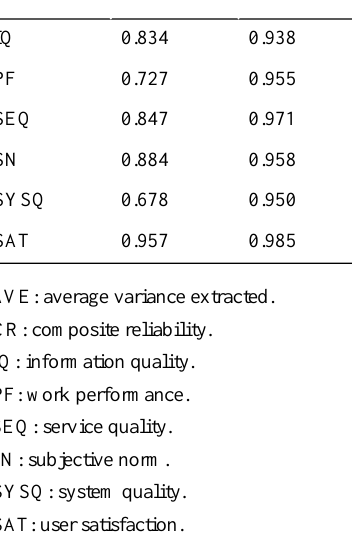
Score, mean (SD) P value F valueVariable